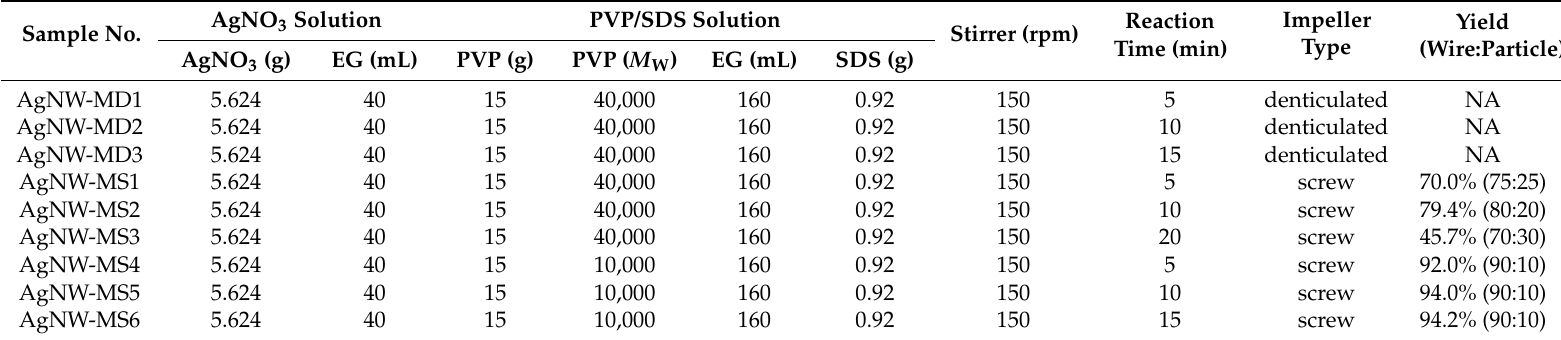
Table 2. Synthesis of AgNWs in batch type resin kettle